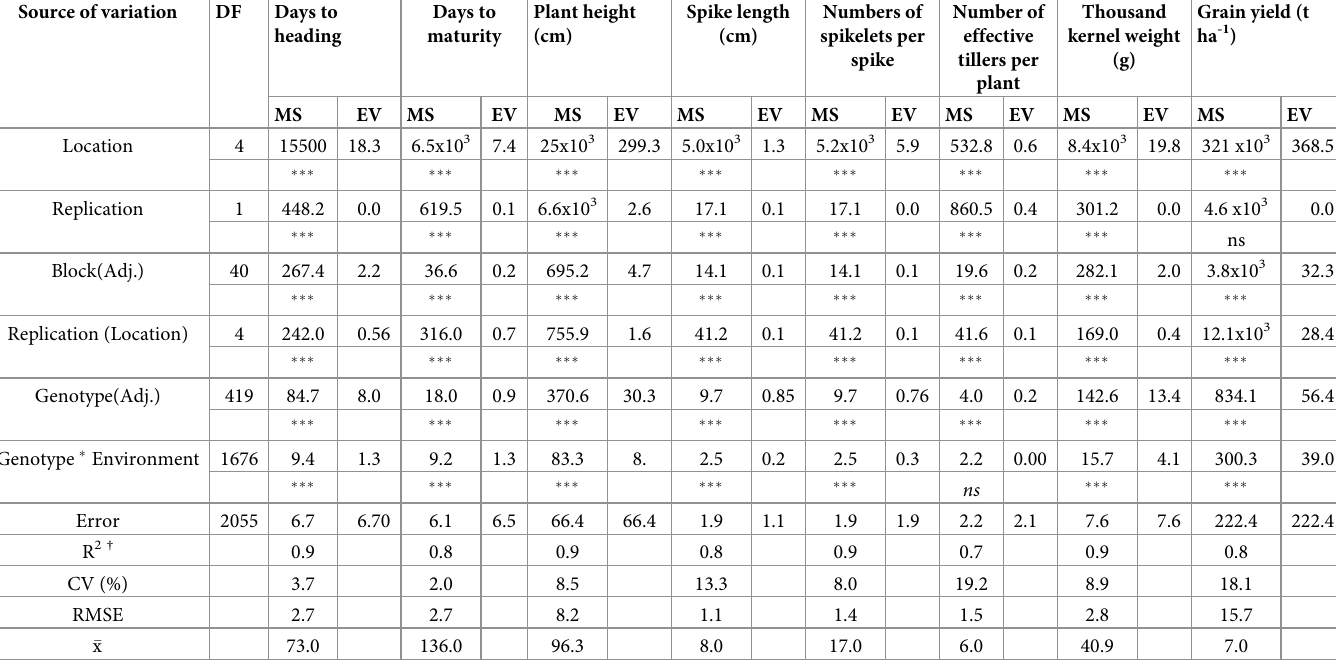
Table 2. Mean square (MS) and estimated variance (EV) for each source of variation of eight traits across 420 Ethiopian durum wheat genotypes tested at five envi- ronments during the main cropping season of 2019–2020. Source of variation DF Days to heading